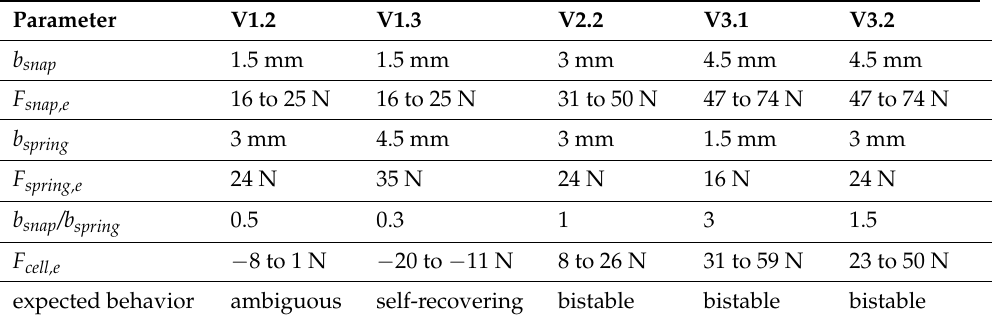
Table 1. Mechanical properties of the unit cell designs based on numerical simulations for a friction coefficient µ = 0.4 and µ = 0.7, where the smaller force value of the depicted range of Fsnap,e and Fcell,e corresponds to the smaller friction coefficient and vice versa.